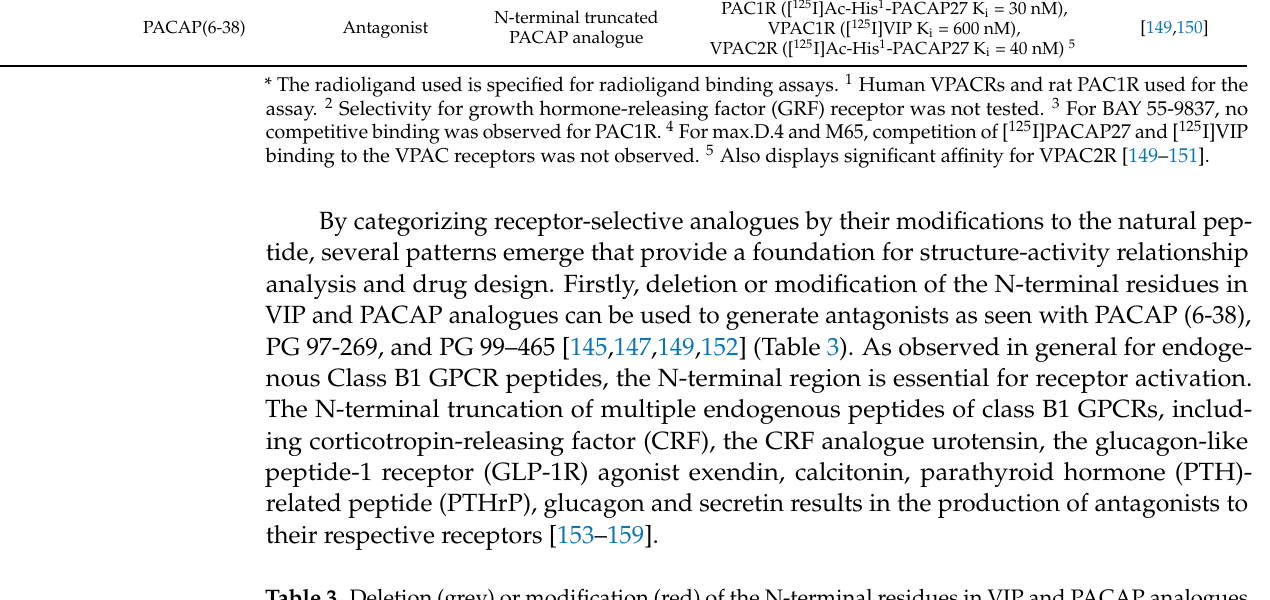
Table 3. Deletion (grey) or modification (red) of the N-terminal residues in VIP and PACAP analogues can be used to generate receptor-selective peptide